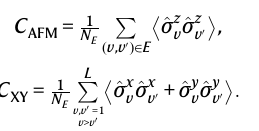
Fig. 5 | Properties of the ground-state of the spin 1/2 XXZ Hamiltonian on the ‘ maximallyirregulargraph ’ whereeachpairofvertices,otherthantwo,havea differentdegree. Graphschematicfor L =10alongsideadjacencymatrixfor L =100 is provided. System sizes are coded by colour. a – f Anti-ferromagnetic order C AFM , XY order C XY , magnetisation density h ^ S z i = L , von-Neumann entanglement entropy between sites V =1... L /2 and V = L /2+1... L and Shannon-Entropy of the z − z and x